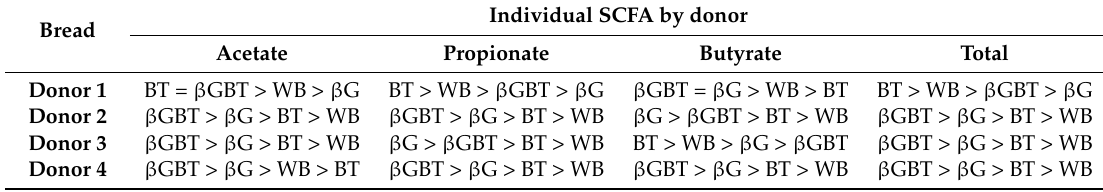
Table 4. Individual SCFA ranking by donor at end of fermentation of different breads after in vitro digestion (24